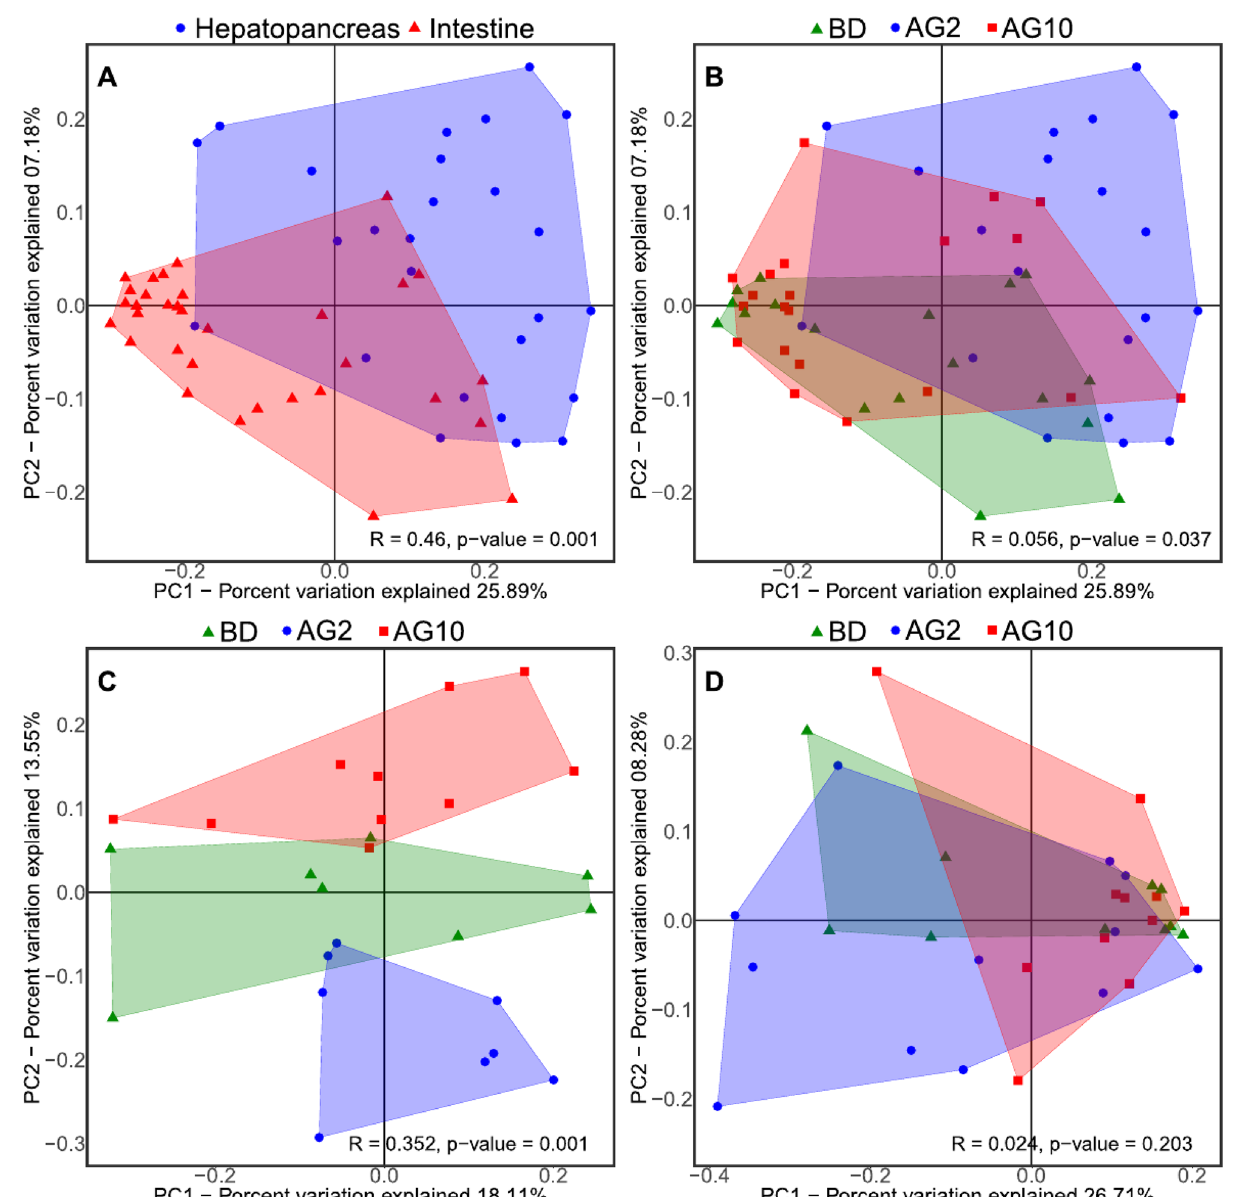
Figure 1. The beta-diversity analysis of microbiota from hepatopancreas and intestine samples. The Unweighted UniFrac distances were used for all PCoA plots. ( A ) Samples tagged by organ. ( B ) Samples tagged by experimental diet. ( C , D ) represent the PCoA plots for the microbiota separating the hepatopancreas ( C ) and intestine ( D ), the samples in both plots were tagged by experimental